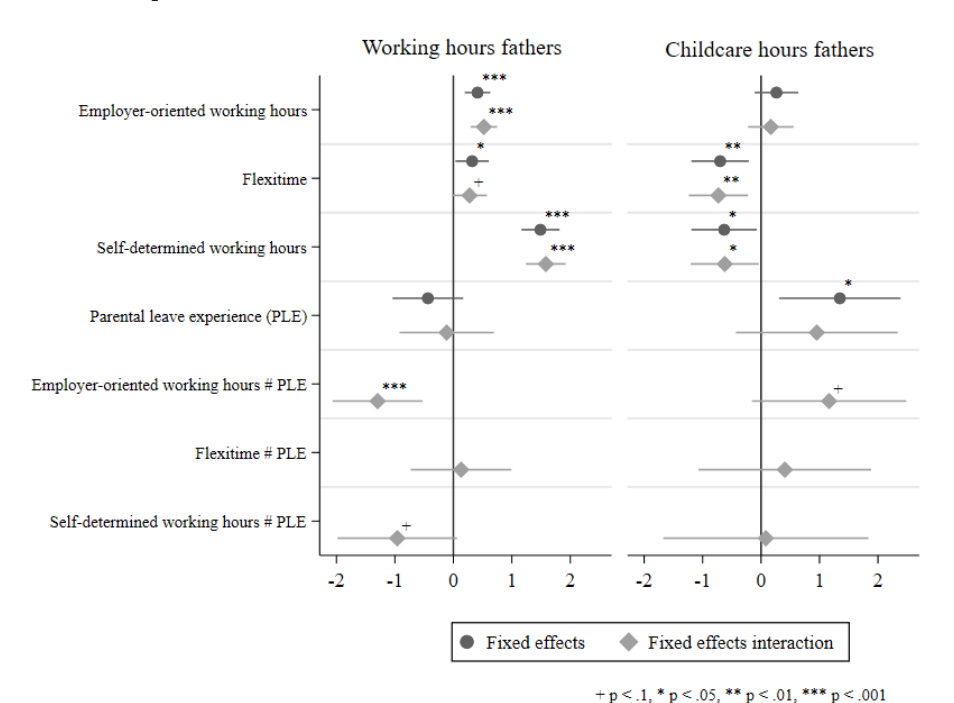
Figure 2 : Fixed effects models for actual working and childcare hours for fathers with interaction between working time arrangements and parental leave